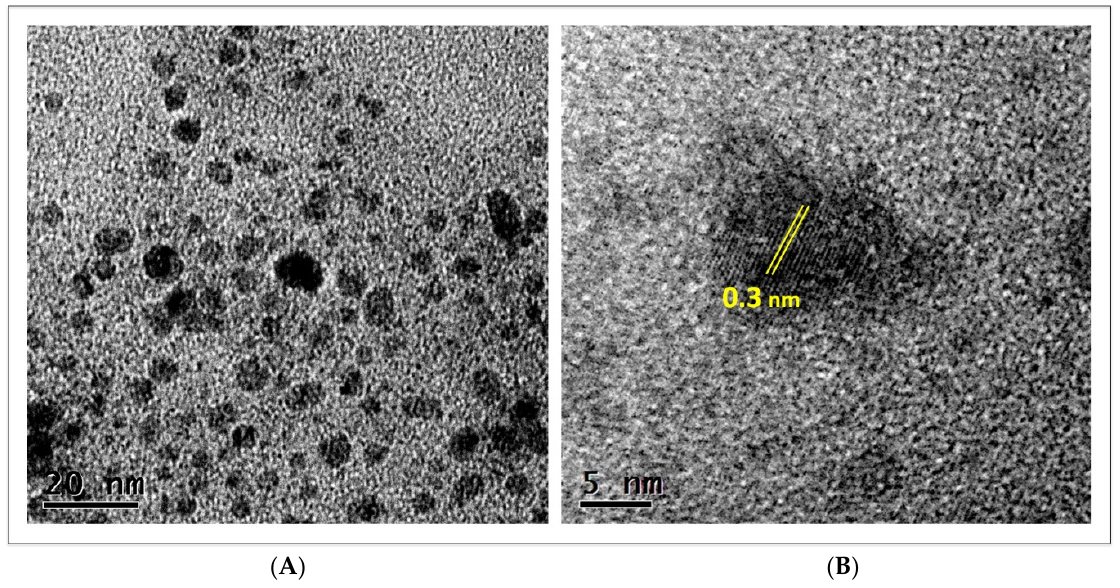
Figure 3. Micrographs of high-resolution transmission electron microscopy of CuONPs synthesized by a biological method; ( A ) image showing polydispersity and variable shape of nanoparticles; ( B ) lattice fringe space of nanoparticles.